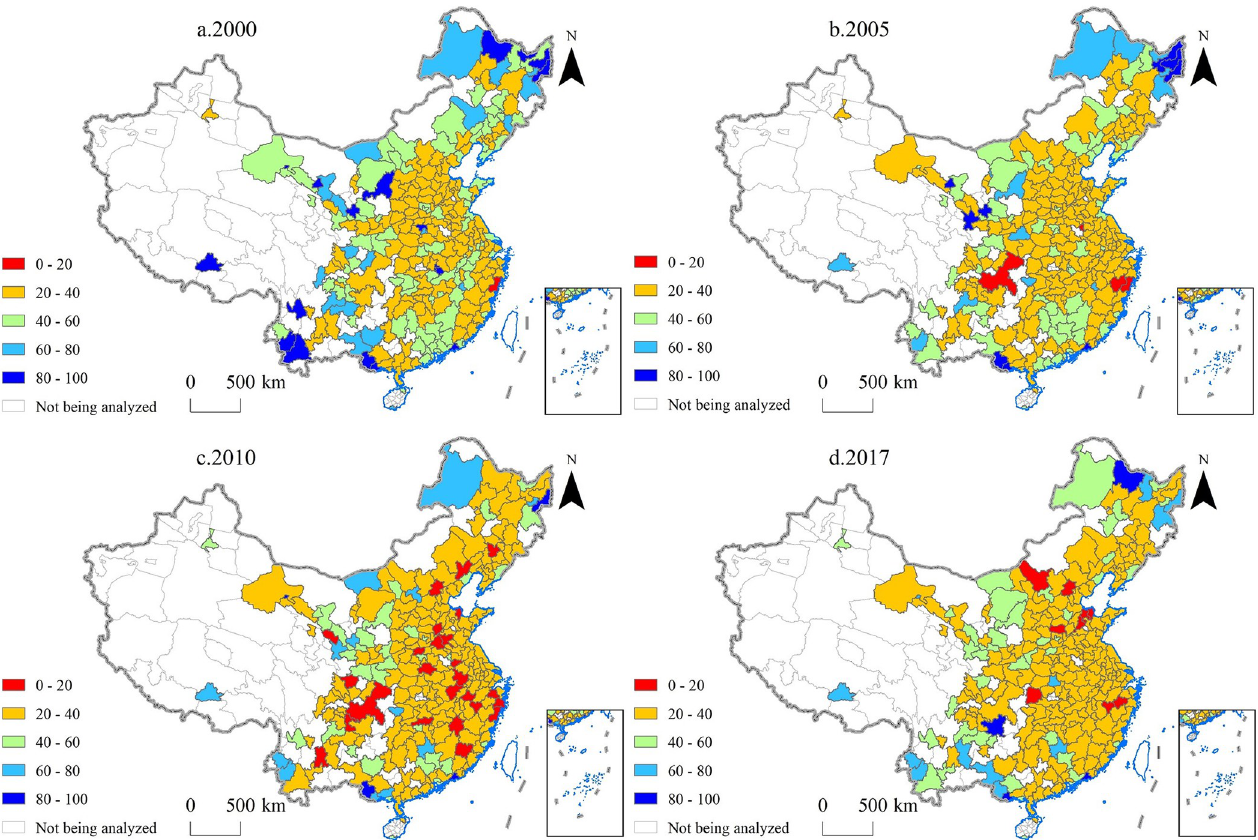
Fig 4. Market concentration index (MCI) of the 270 Chinese cities analyzed in the study in the years 2000, 2005, 2010 and